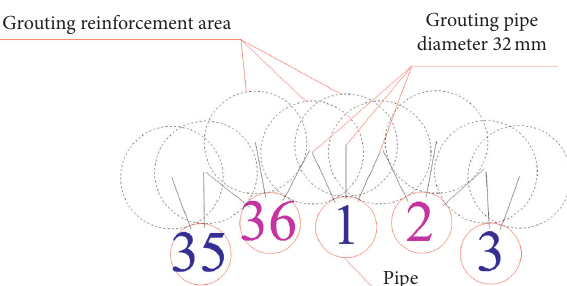
Figure 4: Schematic diagram of grouting for water plugging in the Gongbei